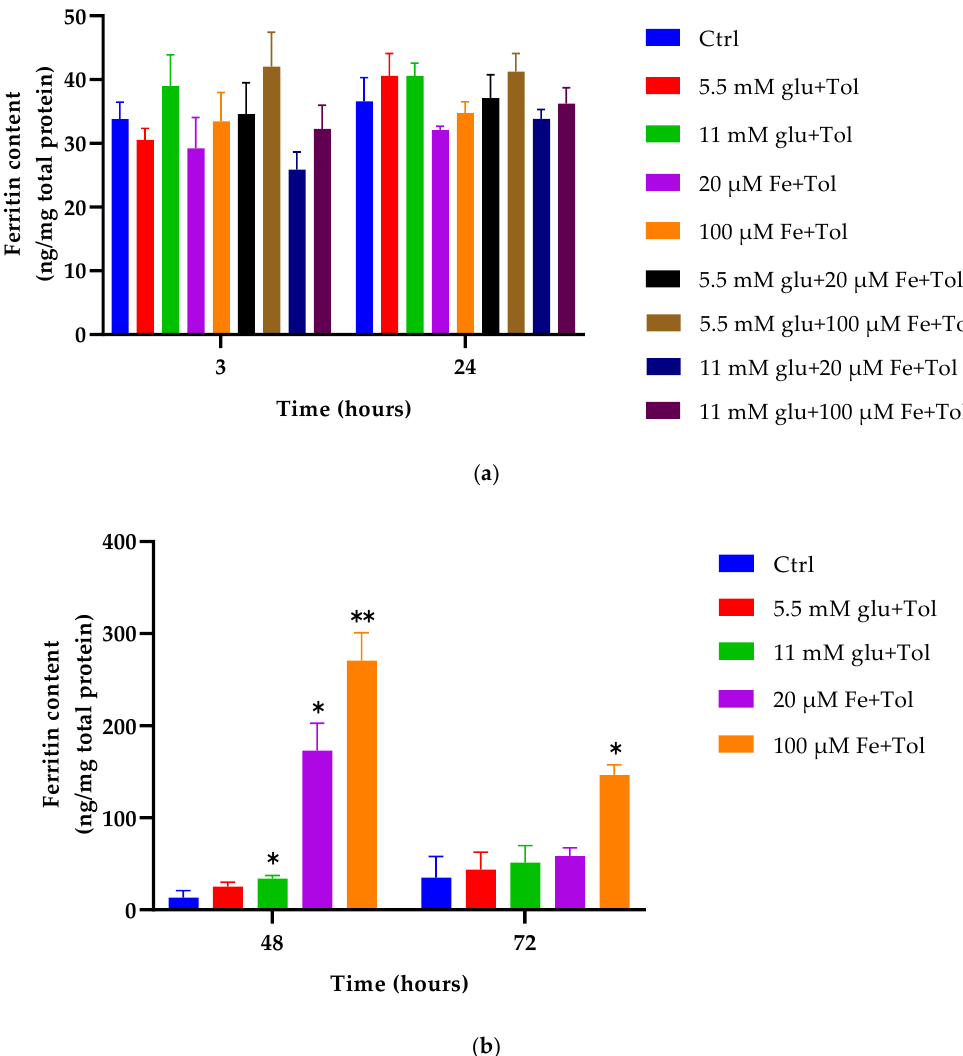
Figure 3. The effect of iron (20 μM and 100 μM), glucose (5.5 mM and 11 mM), and combinations of iron and glucose, all with the addition of tolbutamide as a secretagogue on MIN6 cells on ferritin content. This assessment was performed at four different time points [3 and 24 h ( a ), and 48 and 72 h ( b )]. The data represent mean ± SEM, n = 4. Significance compared to control is as follows * p < 0.028 (11 mM Glu (C2)—48 h), * p < 0.023 (20 μM Fe (C3)—48 h), ** p < 0.006 (100 μM Fe (C4)—48 h); * p < 0.025 (C4—72 h).